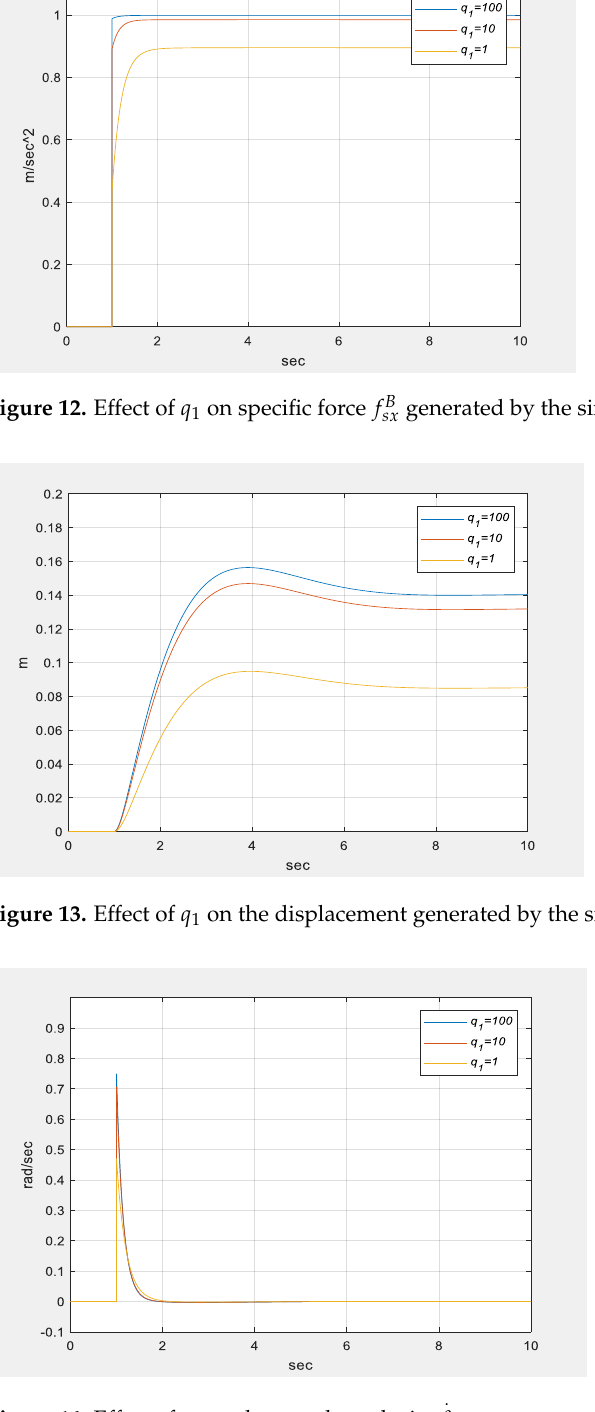
Figure 14. Effect of q 1 on the angular velocity